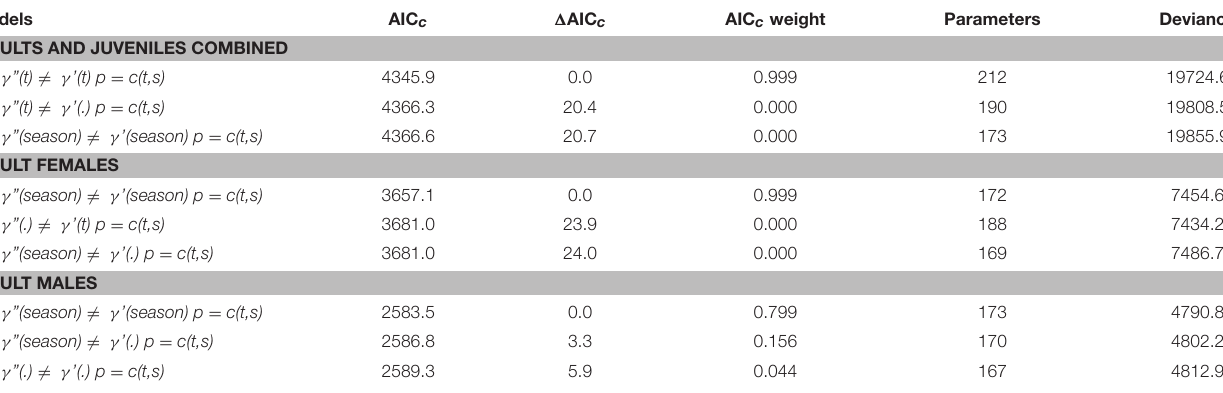
TABLE 3 | The top three Robust Design models, in rank order of AICc scores, for adults and juveniles combined, adult females, and adult males.